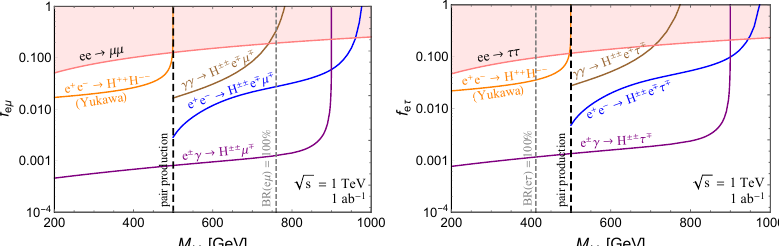
Figure 7. Prospects of the doubly charged scalar mass M ±± and the LFV coupling f e µ ( left ) and f e τ ( right ) at ILC 1 TeV with 1 ab − 1 , in the Yukawa pair (orange) and single production modes of the e + e − (blue), e γ (purple) and γγ (brown) processes. The pink shaded regions are excluded by the LEP e + e − → (cid:96) + (cid:96) − data. The vertical dashed gray lines indicate the current same-sign dilepton limits on the doubly charged scalar mass from LHC, assuming respectively, BR ( H ±± → e ± µ ± ) = 100% and BR ( H ±± → e ± τ ± ) = 100% for the left and right panels . See text for more details. Figure from Ref.